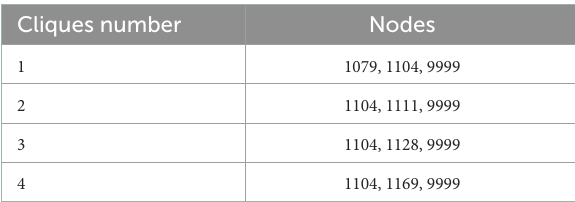
TABLE 3 The cliques of control